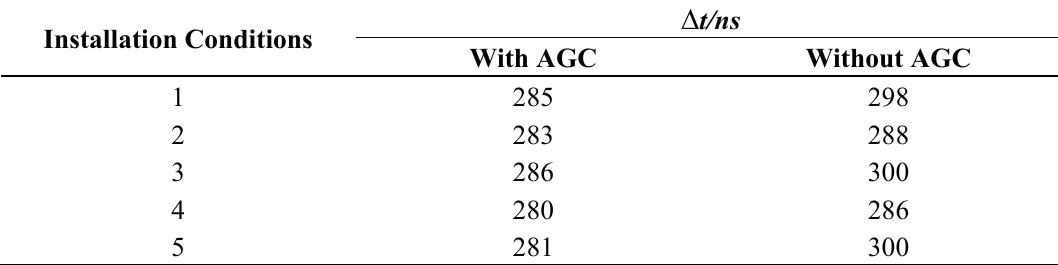
Table 1. Experimental results with different installation